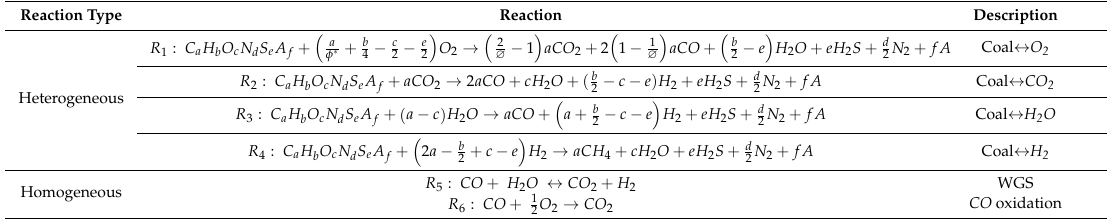
Table 2. Homogeneous and heterogeneous reaction list used in this